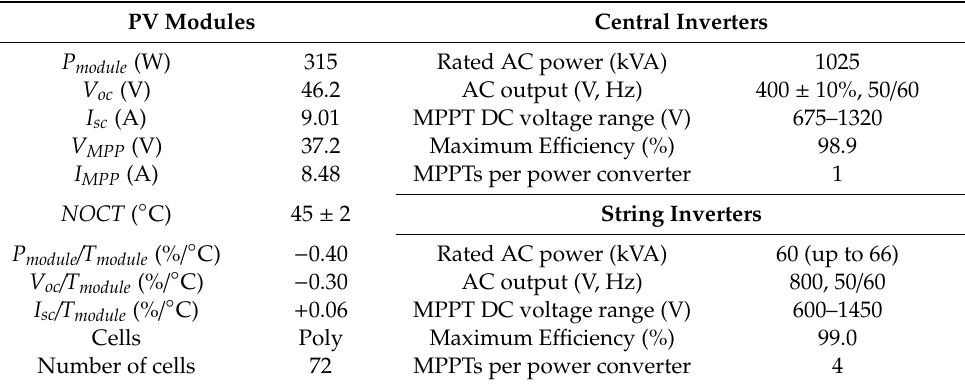
Figure 3. Scheme of the 2.5 MW subfield with string inverters. Table 1. Technical specifications for the main power components.